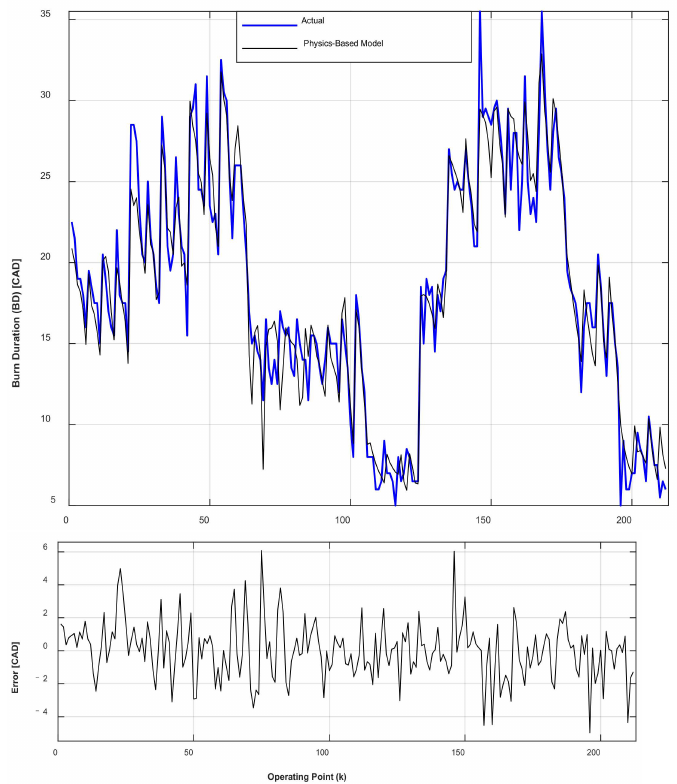
Figure 10. Comparison of the physics-based BD model and actual